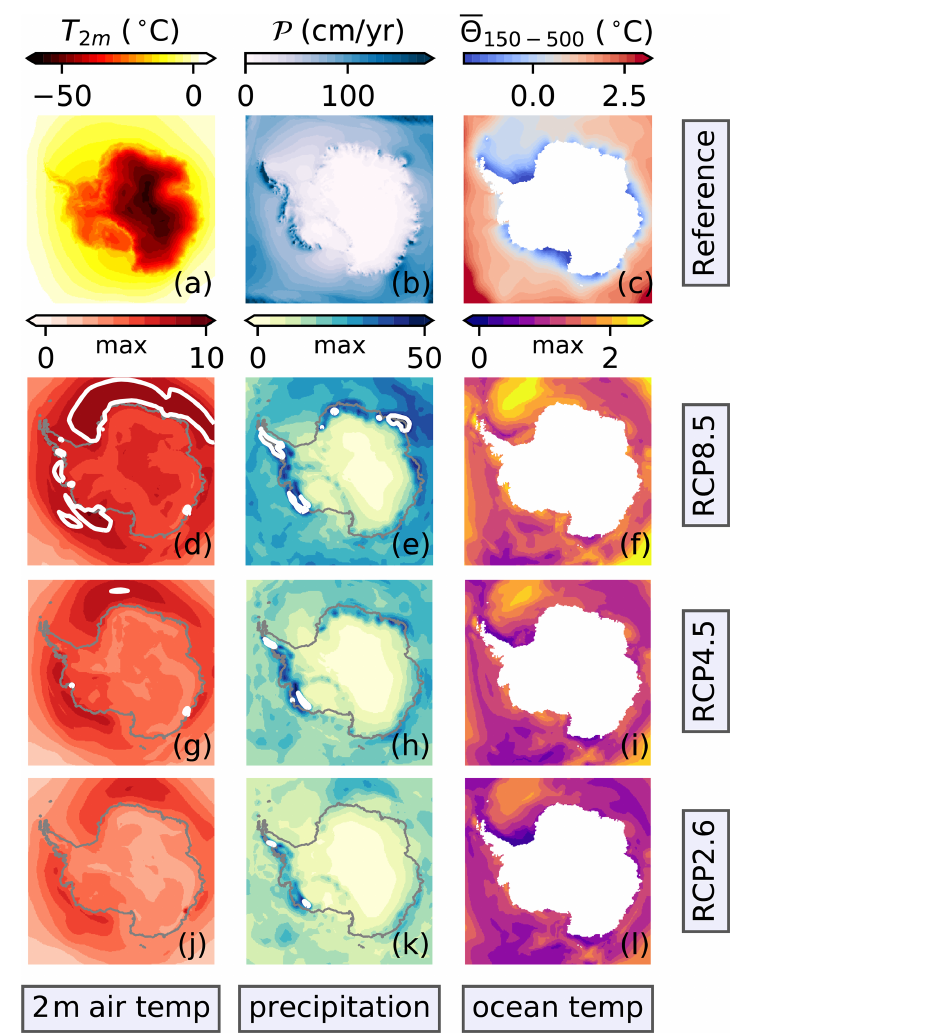
Figure E1. CMIP5 data set maximum anomalies (d–l) relative to the atmospheric (a, b) and oceanographic (c) reference forcing. The corresponding mean and minimum fields are depicted in Figs. 2 and E2, respectively. Panels (a–c) represent the reference fields to spin-up the ice sheet model (Table 2). The 2m air temperature (a) and the total precipitation (b) are mean fields from the regional RACMO model, and the ocean temperatures are from the World Ocean Atlas 2009 (c) . Below each reference field, the related maximum anomalies are compiled for the period from 2071 to 2100. Here, panels (d–f) , (g–i) , and (j–l) show the anomalies for RCP8.5, RCP4.5, and RCP2.6, respectively. The dark-gray line follows the current coastline. All potential ocean temperatures (c, f, i, l) are a vertical mean of the depth interval from 150 to 500m. The white contour lines in the anomaly plots highlight the 2m air temperature threshold (d, g, j) of 8 ◦ C and the total precipitation threshold (e, h, k) of 50cmyr − 1 . All of these anomalies are the CMIP5 data set maximum of the models listed in Table 1; CCSM4 is not part of